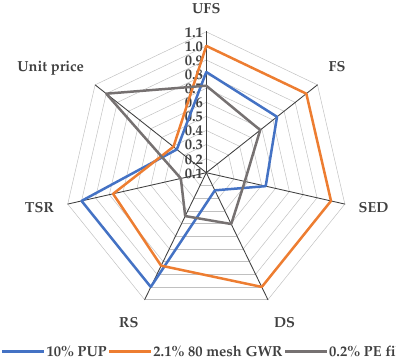
Figure 10. Comprehensive evaluation of different types of modification.